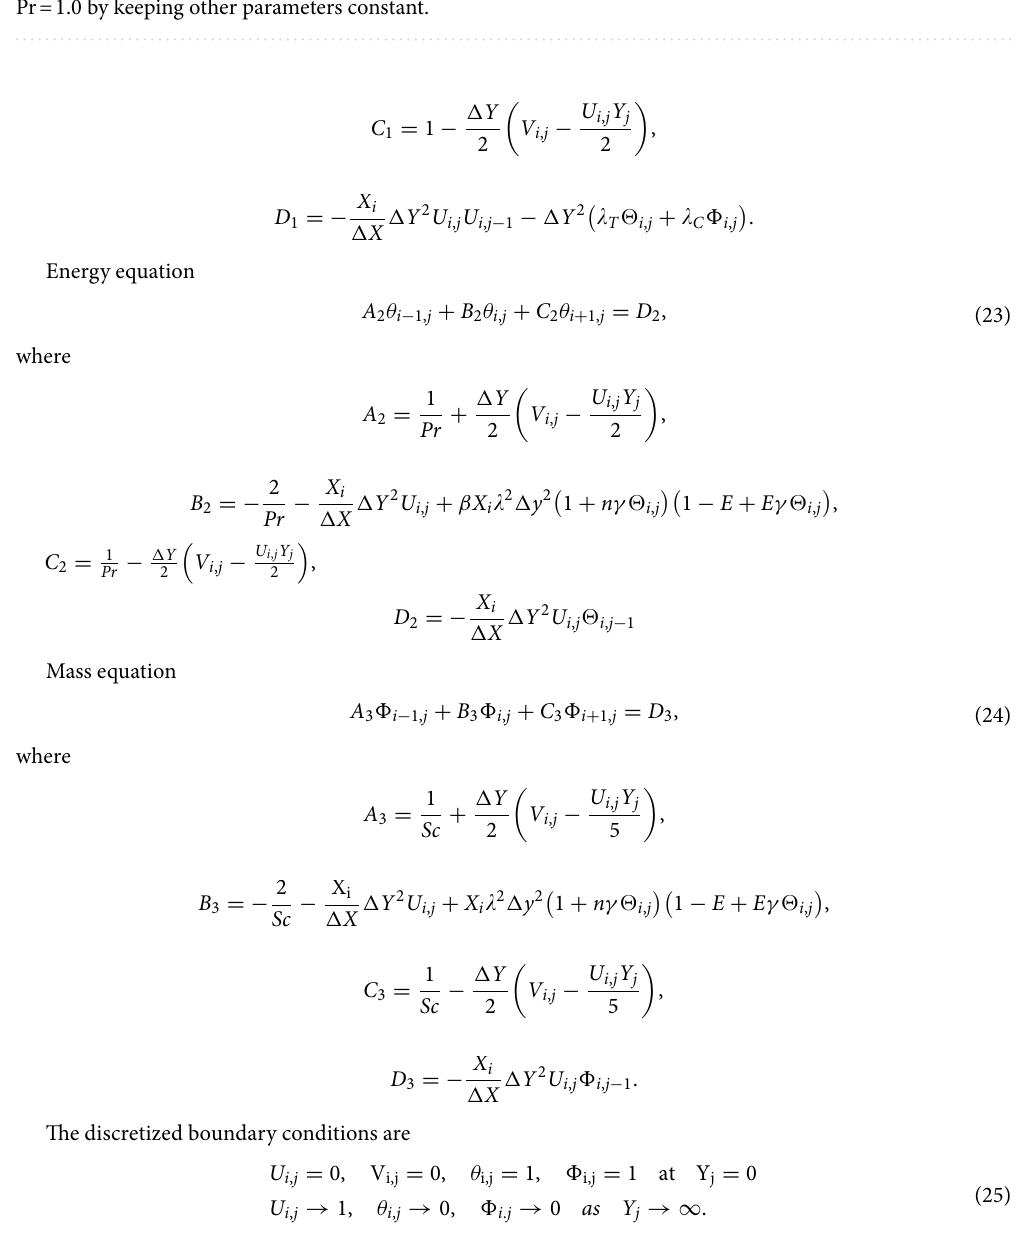
∂ θ by the present result and Pop and Takhar 1 for ∂ Y (cid:31) (cid:30) Y = 0